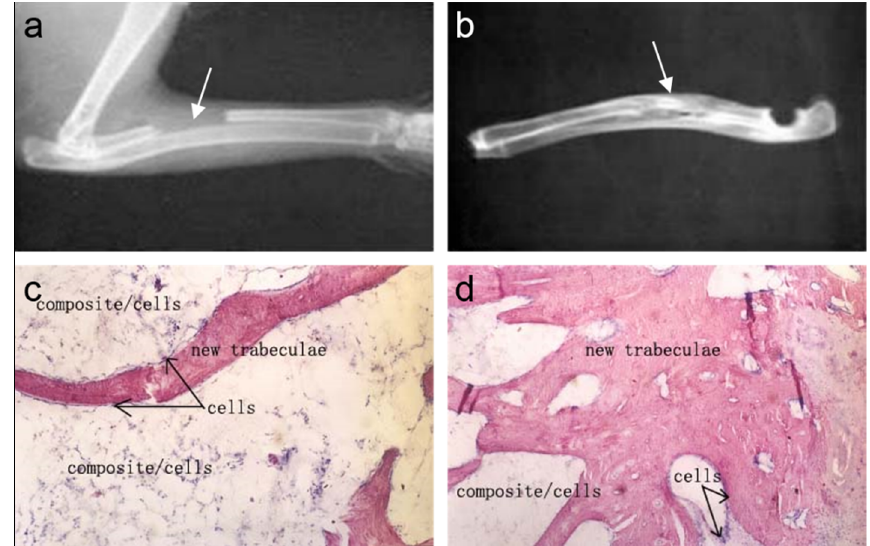
Figure 4. Repair of a critical defect on the rabbit radius by using mineralized collagen: ( a ) After surgery (the defect is noted by the arrow). ( b ) Implant at 12 weeks, double cortical bone connected completely (the regenerated bone tissue is noted by the arrow). ( c ) Implant at eight weeks, decalcified histology hematoxylin-eosin staining. ( d ) Implant at 12 weeks, decalcified histology hematoxylin-eosin staining (compared to eight weeks, more new trabeculae replace the composite). Reprinted with permission from reference